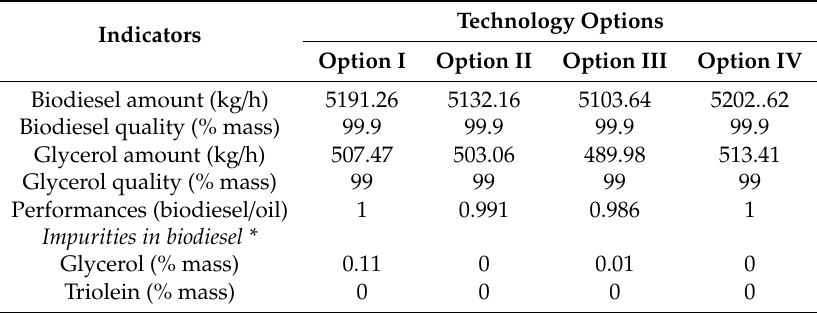
Table 5. Summary of technical performances of the technology